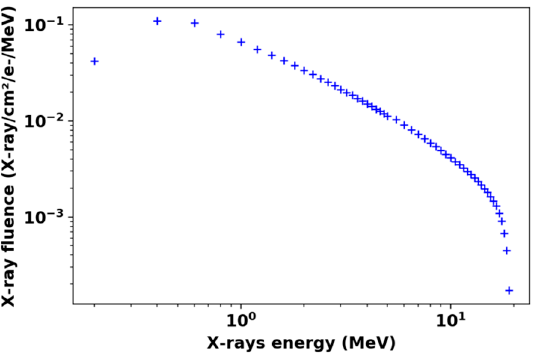
Figure 1. MCNP6 (Monte-Carlo N-Particle Transport Code version 6) [26] simulation of the energy spectrum at 1 cm from the multilayer electron X-ray converter.